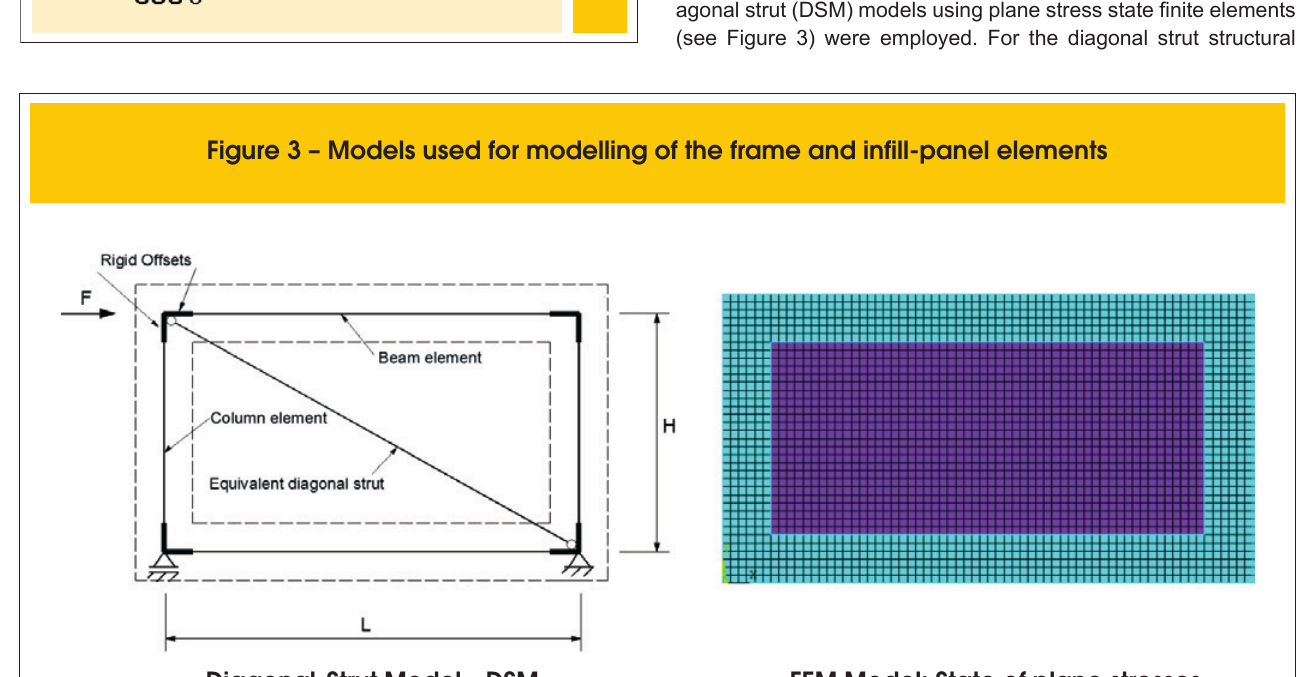
Diagonal-Strut Model -